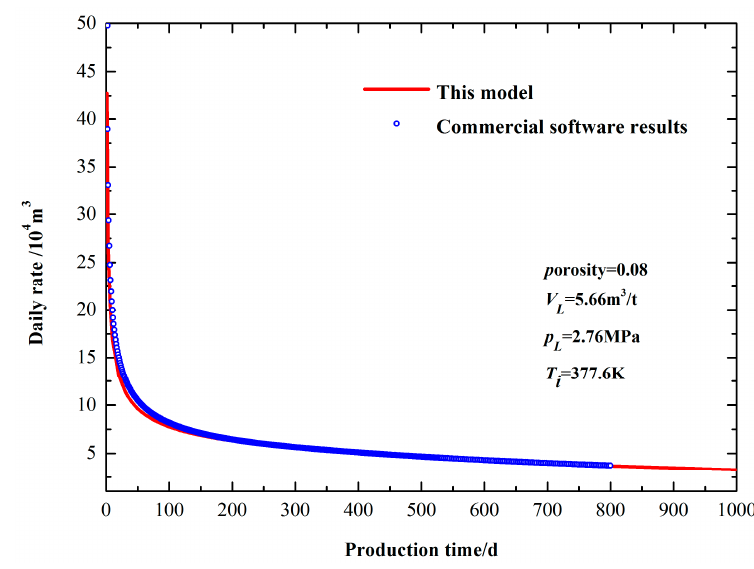
Figure 5. Comparison of flow rate results of this model and commercial software.